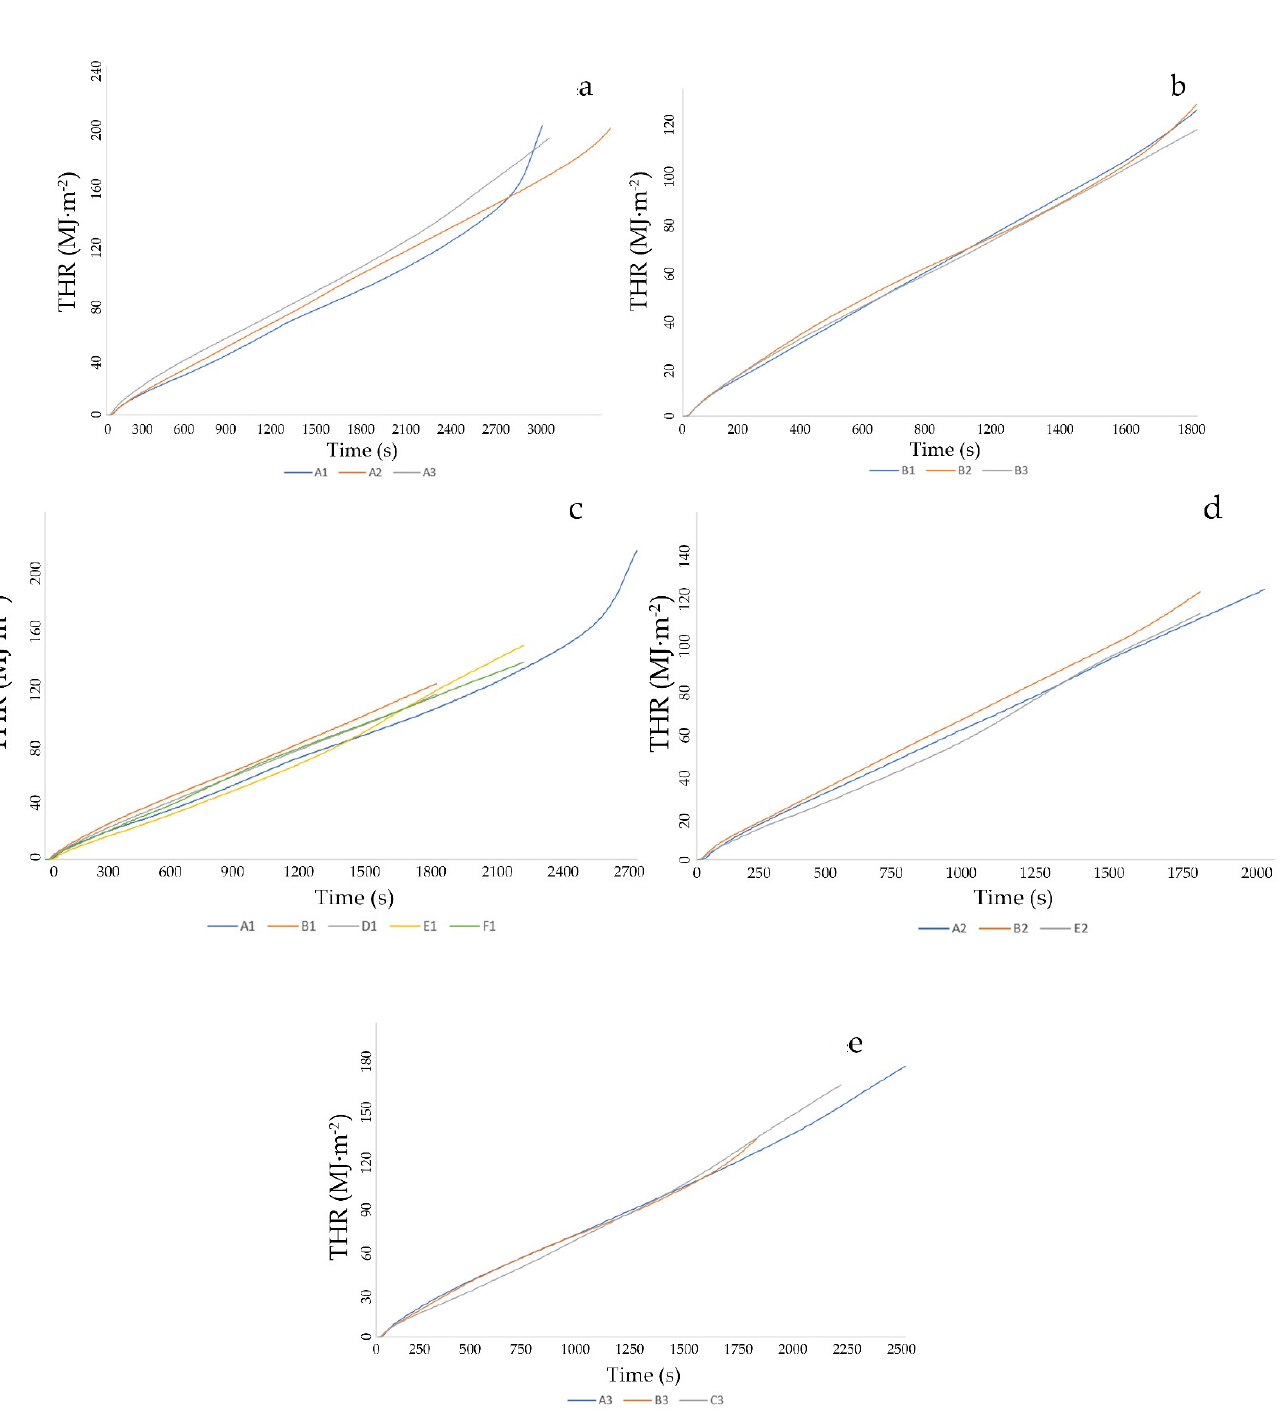
Table 4. Instantaneous charring rates of samples.